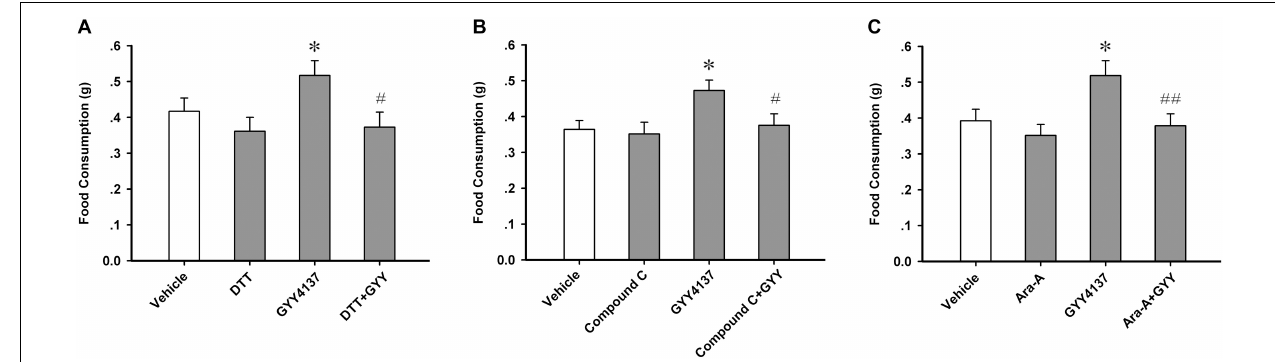
FIGURE 6 | Sulfur-sulfhydrylation and AMPK activation mediate the orexigenic effect of GYY4137. (A) DTT (20 nmol each mouse) attenuated the orexigenic effect of GYY4137 (150.4 mg/kg) ( n = 7). (B) AMPK inhibitor Compound C (100 nmol each mouse) prevented the orexigenic effect of GYY4137 (150.4 mg/kg; n = 7). (C) AMPK inhibitor Ara-A (200 nmol each mouse) prevented the orexigenic effect of GYY4137 (150.4 mg/kg; n = 7). Data are expressed as means ± SEM. One-way ANOVA and post hoc tests were used. ∗ P < 0.05 vs vehicle; # P < 0.05, ## P < 0.01 vs